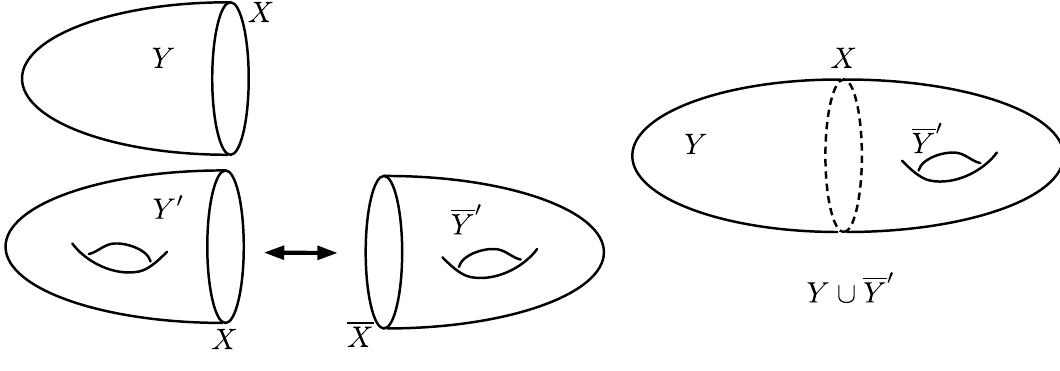
Figure 1 . Schematic pictures of manifolds Y and Y 0 with boundary X , the reversal Y 0 of Y 0 , and the glued manifold Y ∪ Y 0